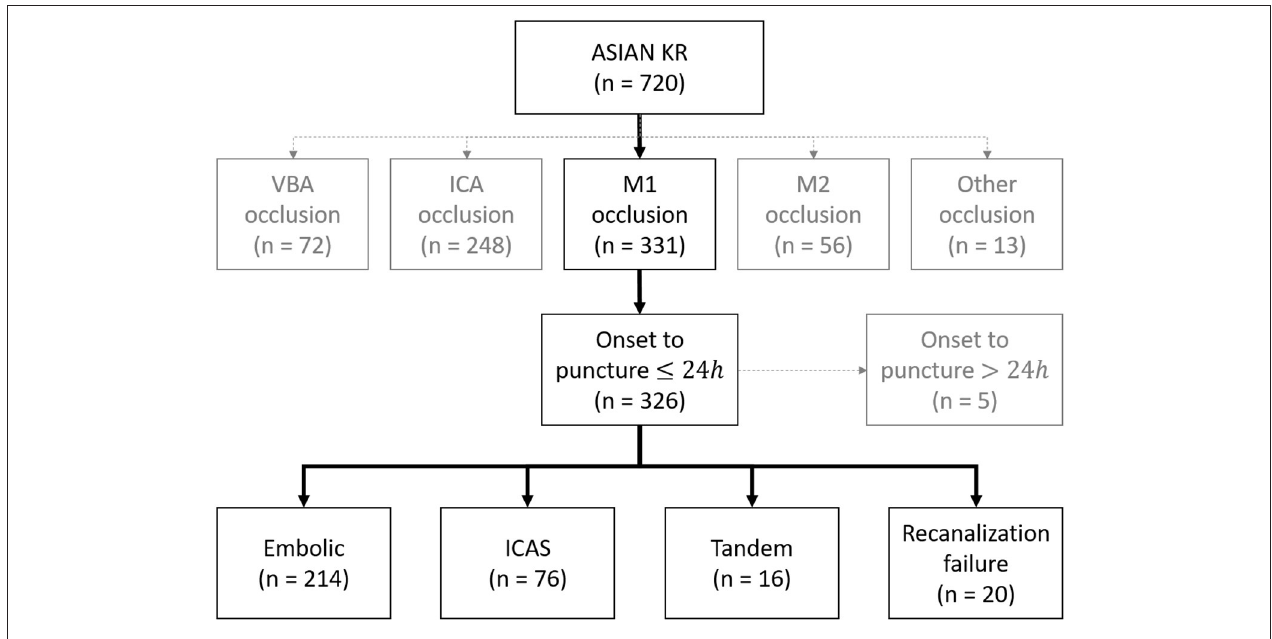
FIGURE 1 | Classification of acute intracranial occlusion based on EVT. ASIAN KR, acute stroke due to intracranial atherosclerotic occlusion and neurointervention-korean retrospective; VBA, vertebrobasilar artery; ICA, internal carotid artery; ICAS, intracranial atherosclerotic stenosis.